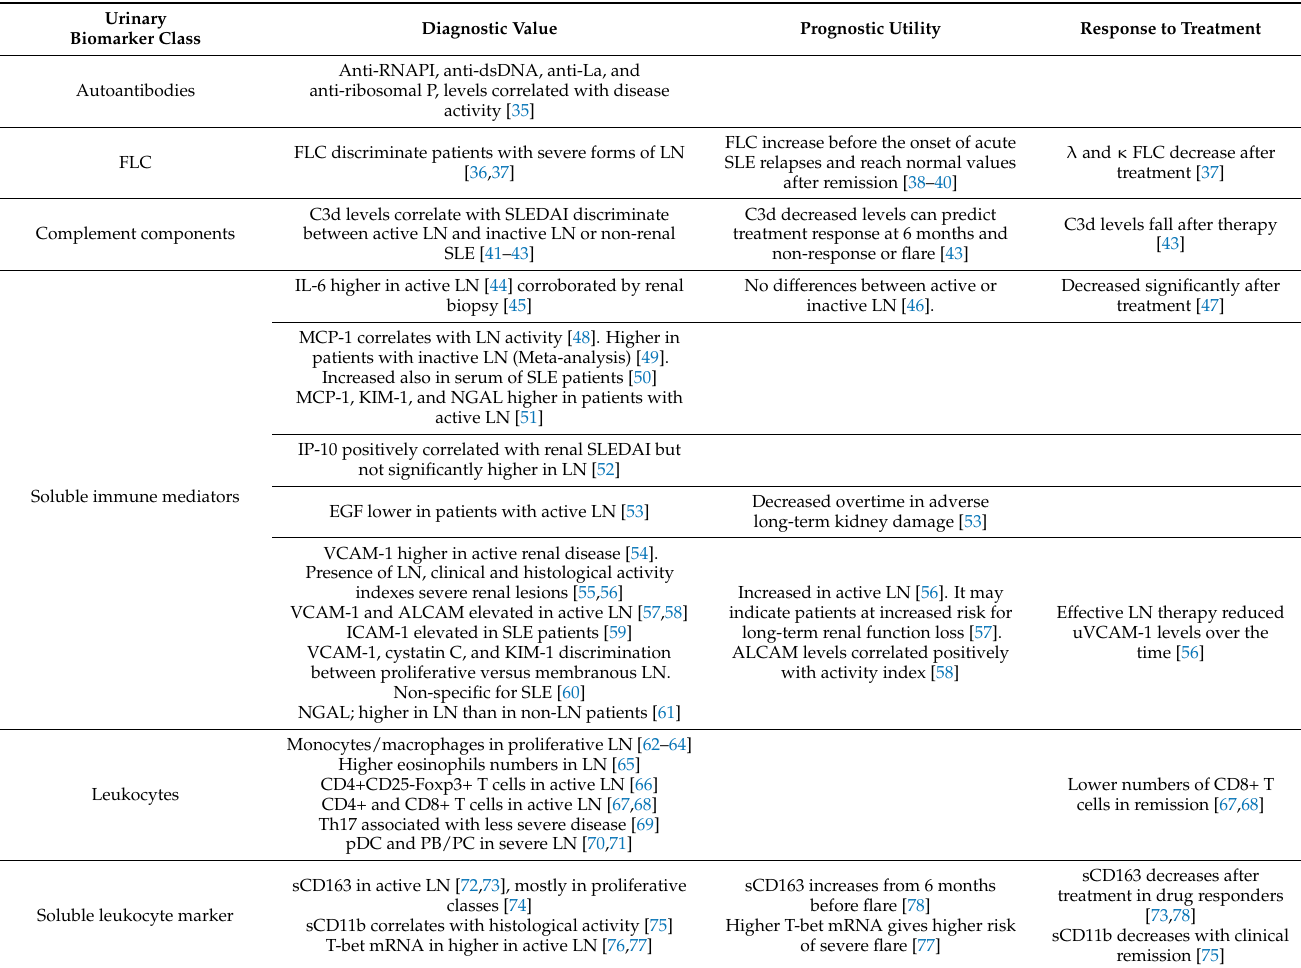
Table 1. Summary of immune-related urinary biomarkers of